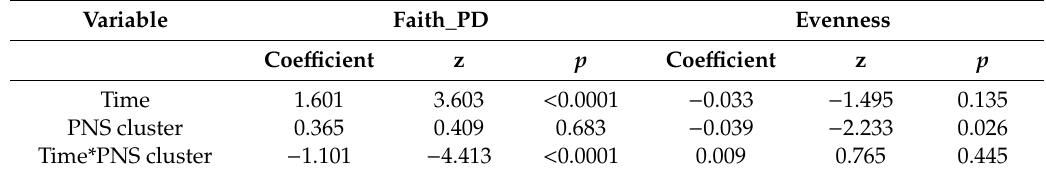
Table 2. Longitudinal association between the gut microbial α -diversity and PNS by time ( n = 13). Variable